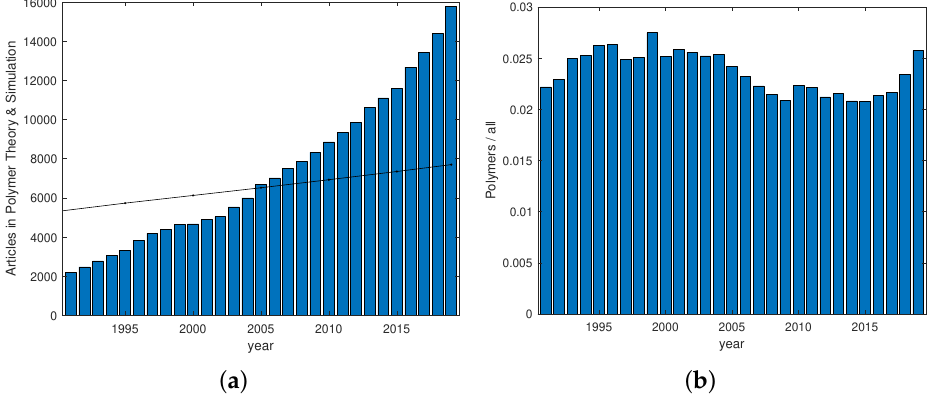
Figure 1. ( a ) Number of peer-reviewed journal articles in the field of polymer theory and simulation within the time range 1991–2019. The black reference line is the population of humans in milliards. ( b ) Fraction of polymer-related articles in the field of theory and simulation. Data from Web of Science (Clarivate Analytics). Approximately 2.5% of all theory and simulation articles are from within the field of